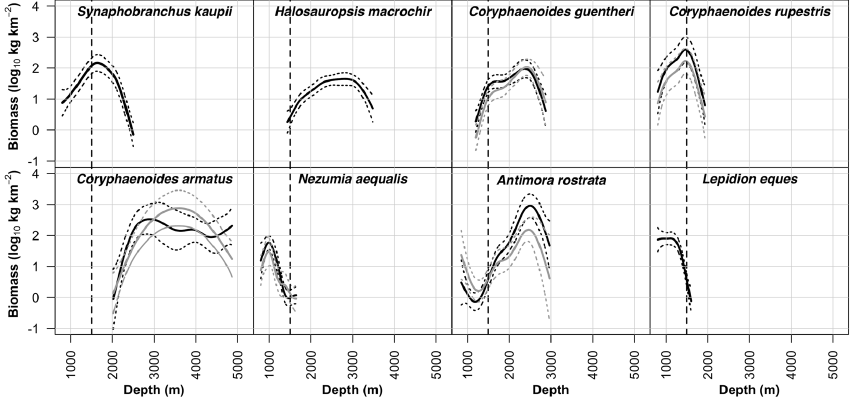
Fig. 4. Biomass trends (log 10 kgkm 2 ) for the eight most dominant species in terms of biomass in the Porcupine Seabight and Abyssal Plain. Model predictions (solid lines) and 95% confidence intervals (dashed lines) are shown for changes in total biomass for individual species with depth in the early (black) and late (grey)